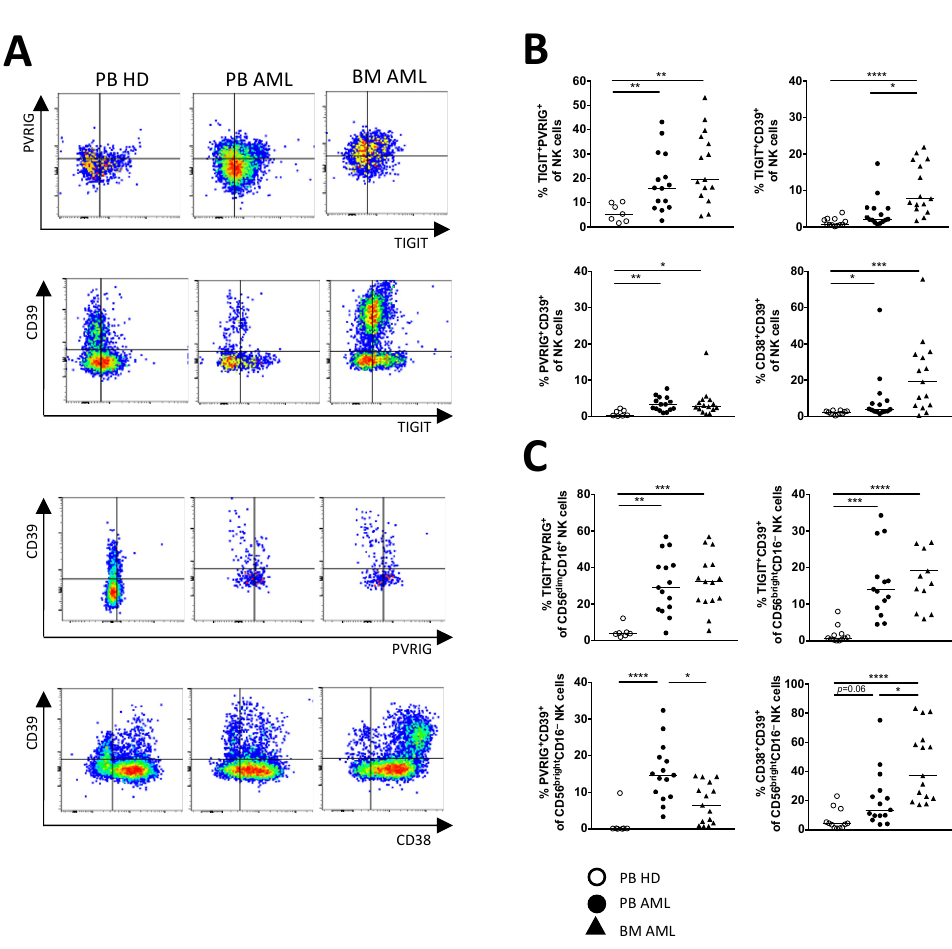
Figure 4. PVRIG and CD39 are co-expressed more frequently with TIGIT on NK cells in AML. Dual co-expression of the checkpoint molecules was analyzed in the peripheral blood (PB, n = 15) and bone marrow (BM, n = 25, except for PVRIG n = 15 due to a converted MFC panel) from AML patients and was compared with the PB from HDs ( n = 12, for PVRIG n = 7). ( A ) Representative flow cytometry plots illustrate the co-expression of the checkpoint molecules. ( B ) Summary data show the co-expression of TIGIT, PVRIG, CD39, and CD38 on the total NK cell fraction. ( C ) Relevant co- expression of TIGIT, PVRIG, CD39, and CD38 is displayed on CD56 bright CD16 − and CD56 dim CD16 + NK cells. p values were obtained by the ANOVA and Kruskal–Wallis test. * p < 0.05, ** p < 0.01, *** p < 0.001, **** p <